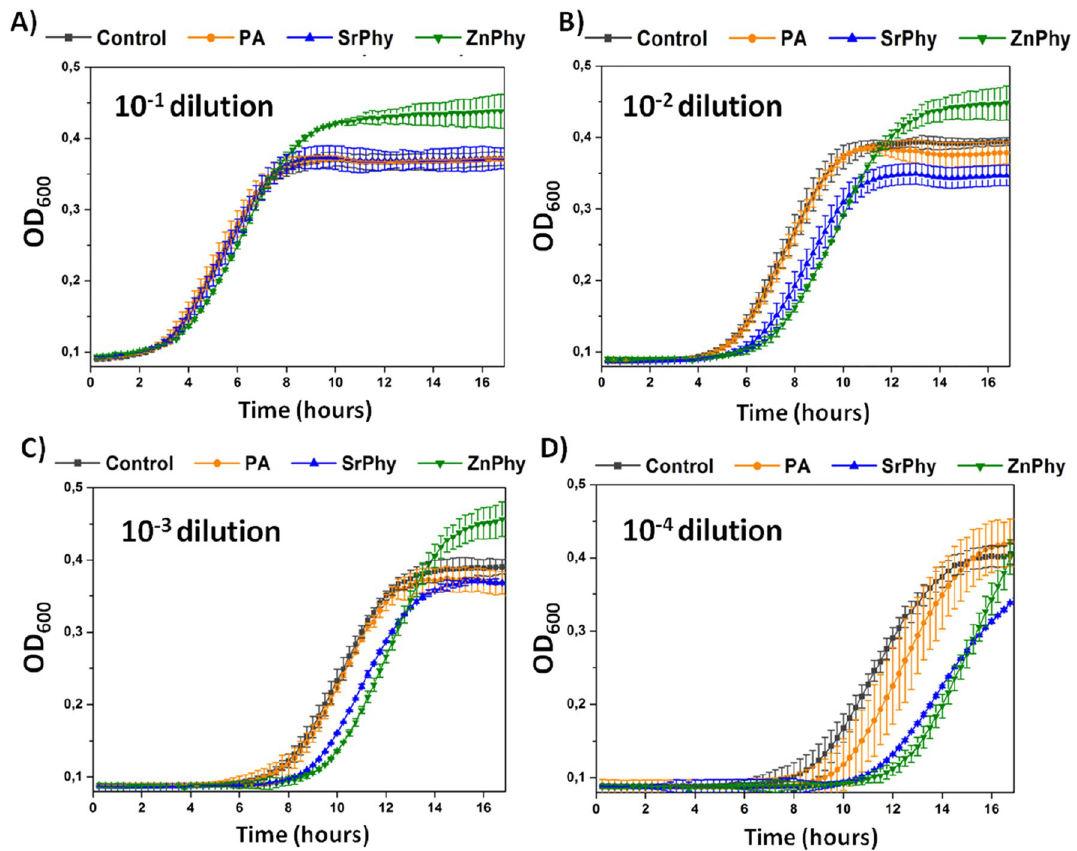
mutans culture at OD 600 0.2, grown under treatments with phytate compounds (50 µg/mL). The control sample was a diluted culture growth in BHI:Tris–HCl